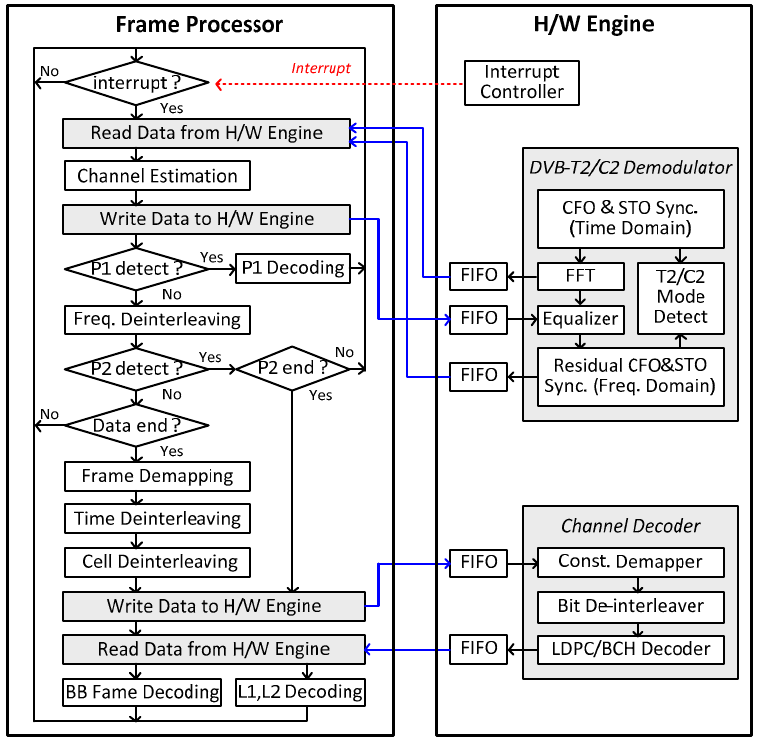
Figure 8. Example of data transfer between the frame processor and H/W engine.